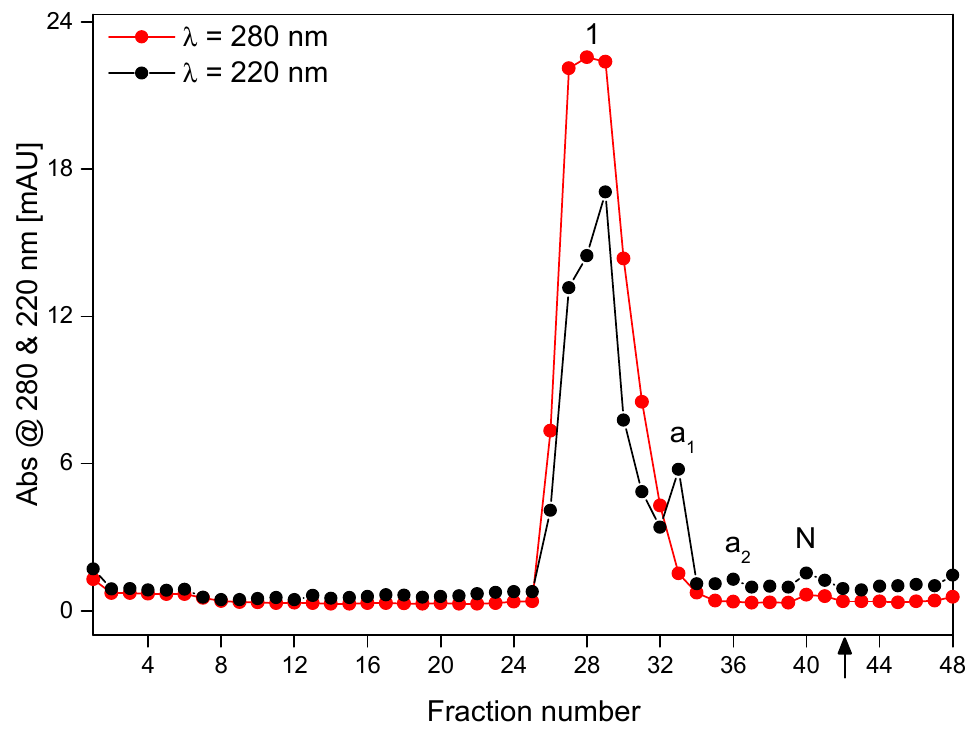
Figure 5. FFZE separation of dipeptide β -Ala-Tyr obtained by HPLC separation of an extract from the hemolymph of the larvae of Neobellieria bullata . 1, β -Ala-Tyr; a 1 , a 2 , non-identified admixtures; N, noncharged sample component. Carrier BGE: 500 mM AcOH, pH 2.50; separation voltage 3.0 kV; current 122–125 mA; sample flow rate 1.6 mL/h; flow-through time 31 min; sample concentra- tion 30 mg/mL, total sample amount 63.8 mg. The arrow at fraction no. 42 indicates the position, at which the sample is continuously introduced at the inlet side of the flow-through (free-flow) chamber. For other experimental conditions, see Section 2.3.2.